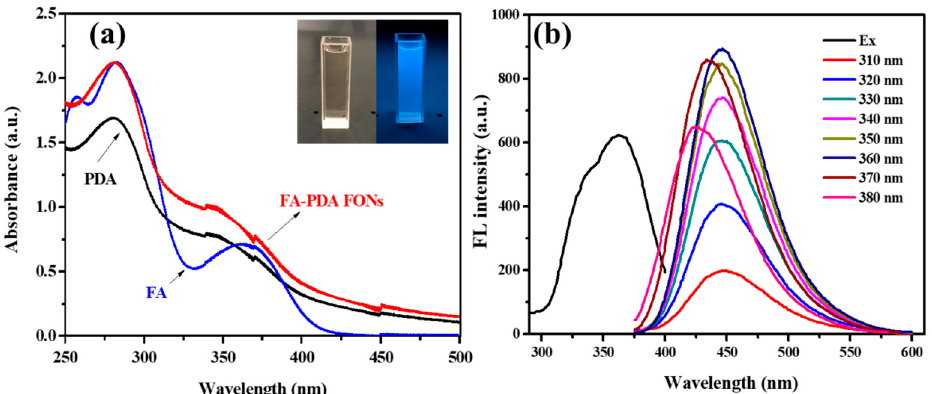
Figure 5. ( a ) UV-vis absorption spectra of FA, PDA and FA-PDA FONs. Inset shows the photographs of FA-PDA FONs probe under the natural light (left) and the irradiation of 365 nm UV lamp (right); ( b ) Excitation and fluorescence spectra of FA-PDA FONs with the excitation wavelength increased from 310 to 380